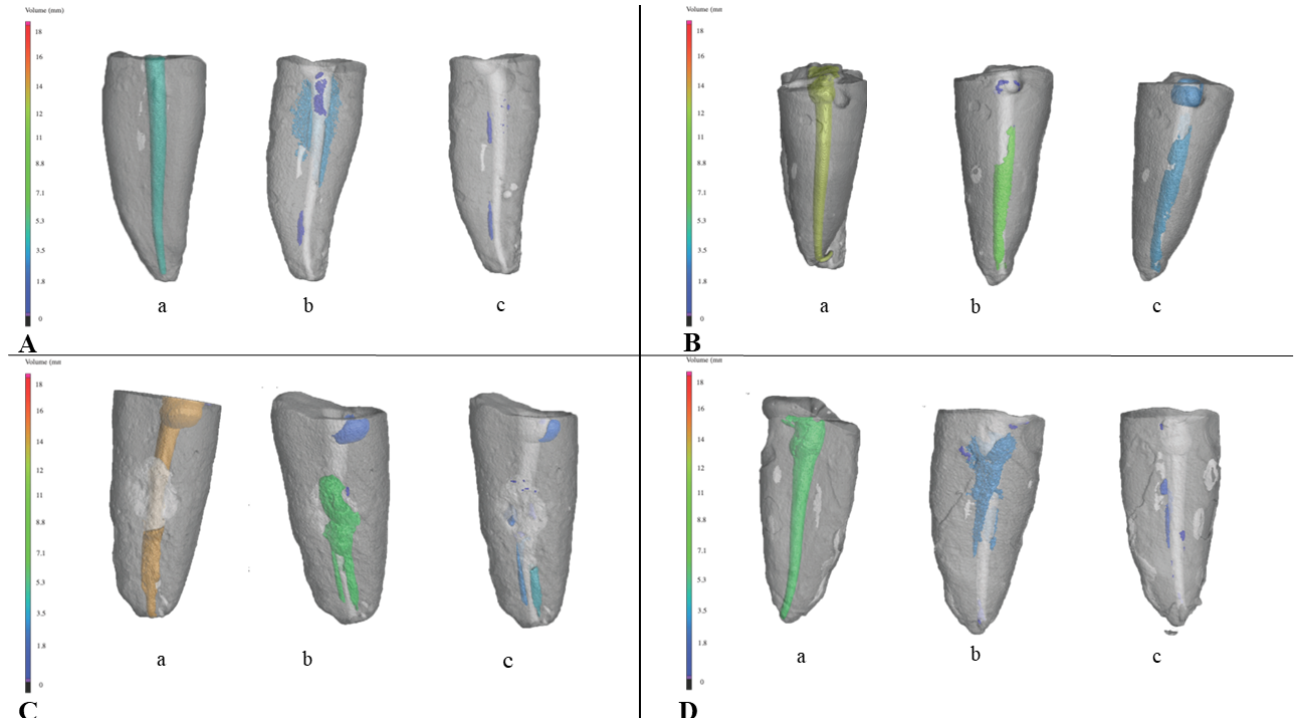
Figure 1. Three-dimensional model of a single canal tooth obtained by micro-CT scanning: (a)— after root canal filling; (b)—after re-treatment with Reciproc instruments; and (c)—after additional SWEEPS treatment. Root canal filling and the root canal filling remnants are colored according to the volume of the root canal filling in: ( A ) Group 1: single-cone group, AH Plus + gutta-percha; ( B ) Group 2: single-cone group, TotalFill BC+ TotalFill BC Points, ( C ) Group 3: core-carrier group AH Plus + Guttafusion; ( D ) Group 4: core-carrier group, MTA Fillapex +